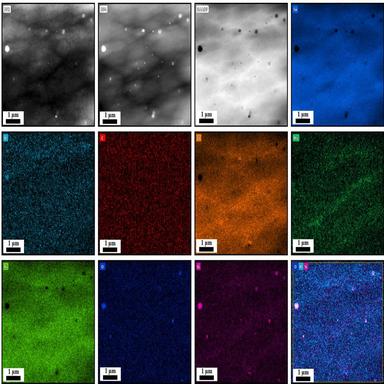
The relating HR-STEM/EDS elemental mapping analysis results show the contribution of Al2O3 nanoparticles through the steel matrix after LPBF printing.